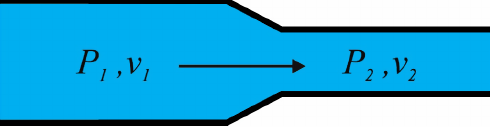
FIG. 1. Flow along a narrowing pipe. P 1 and v 1 ( P 2 and v 2 ) indicate the pressure and the velocity before (after) the narrowing.